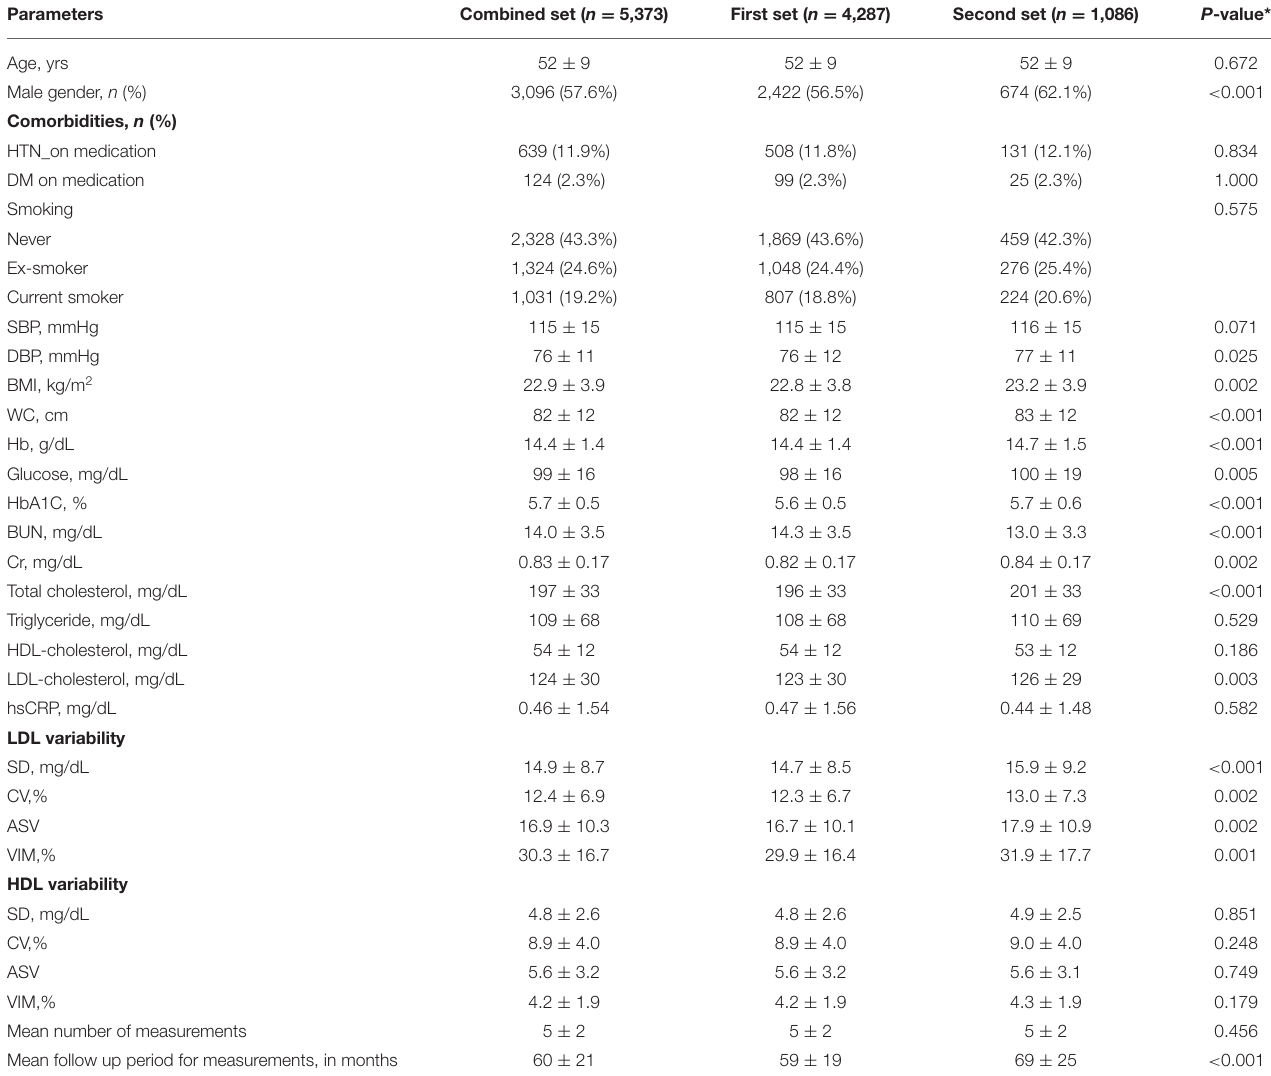
TABLE 1 | Baseline characteristics of the study